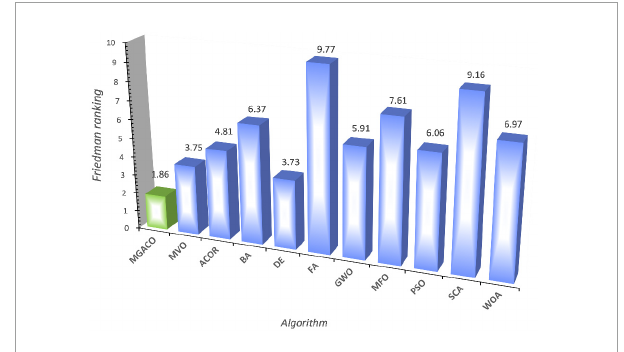
FIGURE8 Friedman test results of MGACO and its 10 basic